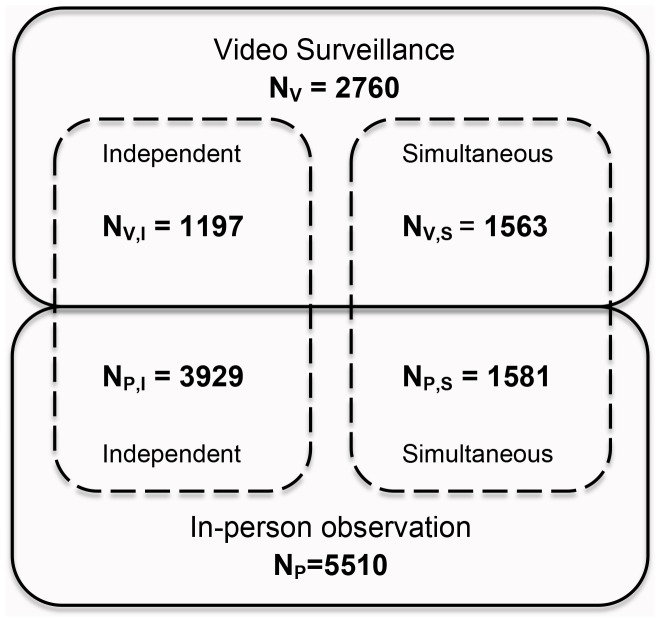
Schematic of study design.Number of toileting events captured on video surveillance (NV) and through in-person observation (NP), during independent (single-method) versus simultaneous monitoring periods.